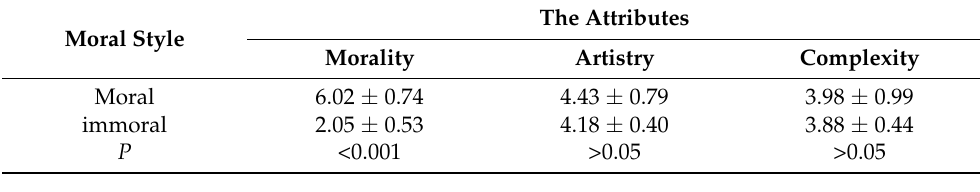
Table 1. The mean rating scores of different behavior styles in different attributes.